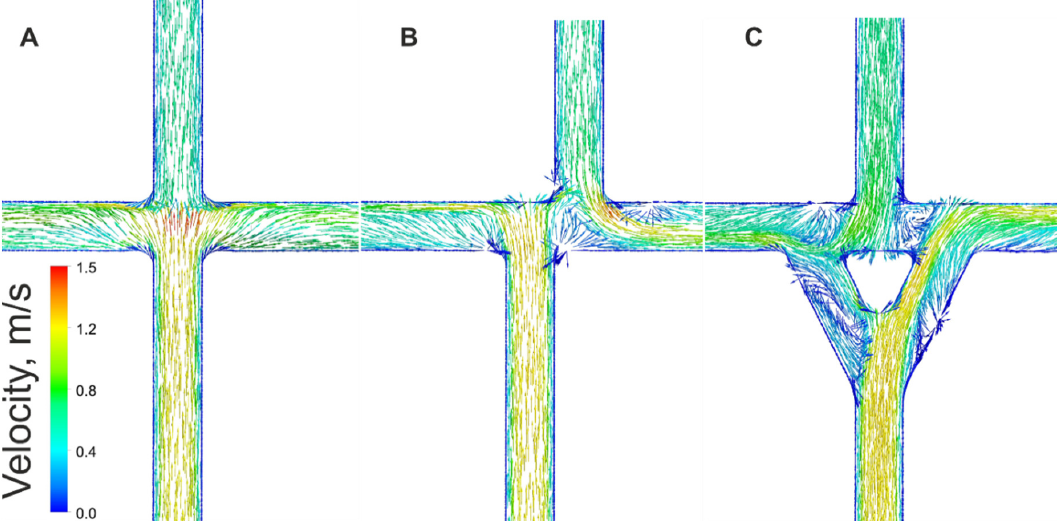
Figure 6. Distribution of the flow velocity vector field obtained by the computational fluid dynamics (CFD) simulation. Velocity values for the color gradient are given in the sub picture. Flows from inferior and superior vena cava bump into each other that increases the hydraulic losses. Flows in TCPC ‐ 2 and TCPC ‐ 3 are divided into two parts, effectively decreasing hydraulic losses.